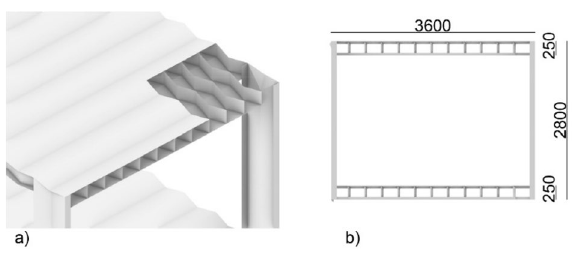
Figure 5. The proposed origami-like modular unit. ( a ) Axonometry. ( b ) Side